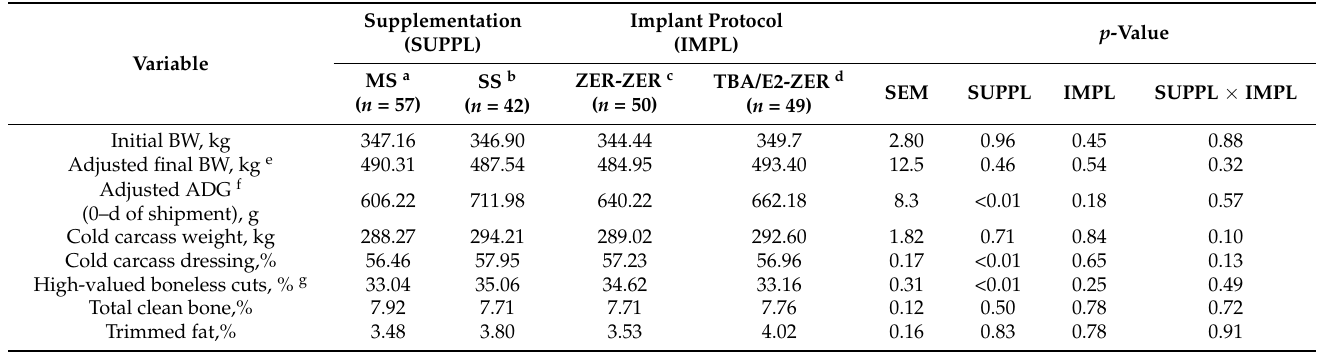
Table 3. Growth and fabrication yield traits of bull carcasses according to supplementation and implant treatments (Experiment I).